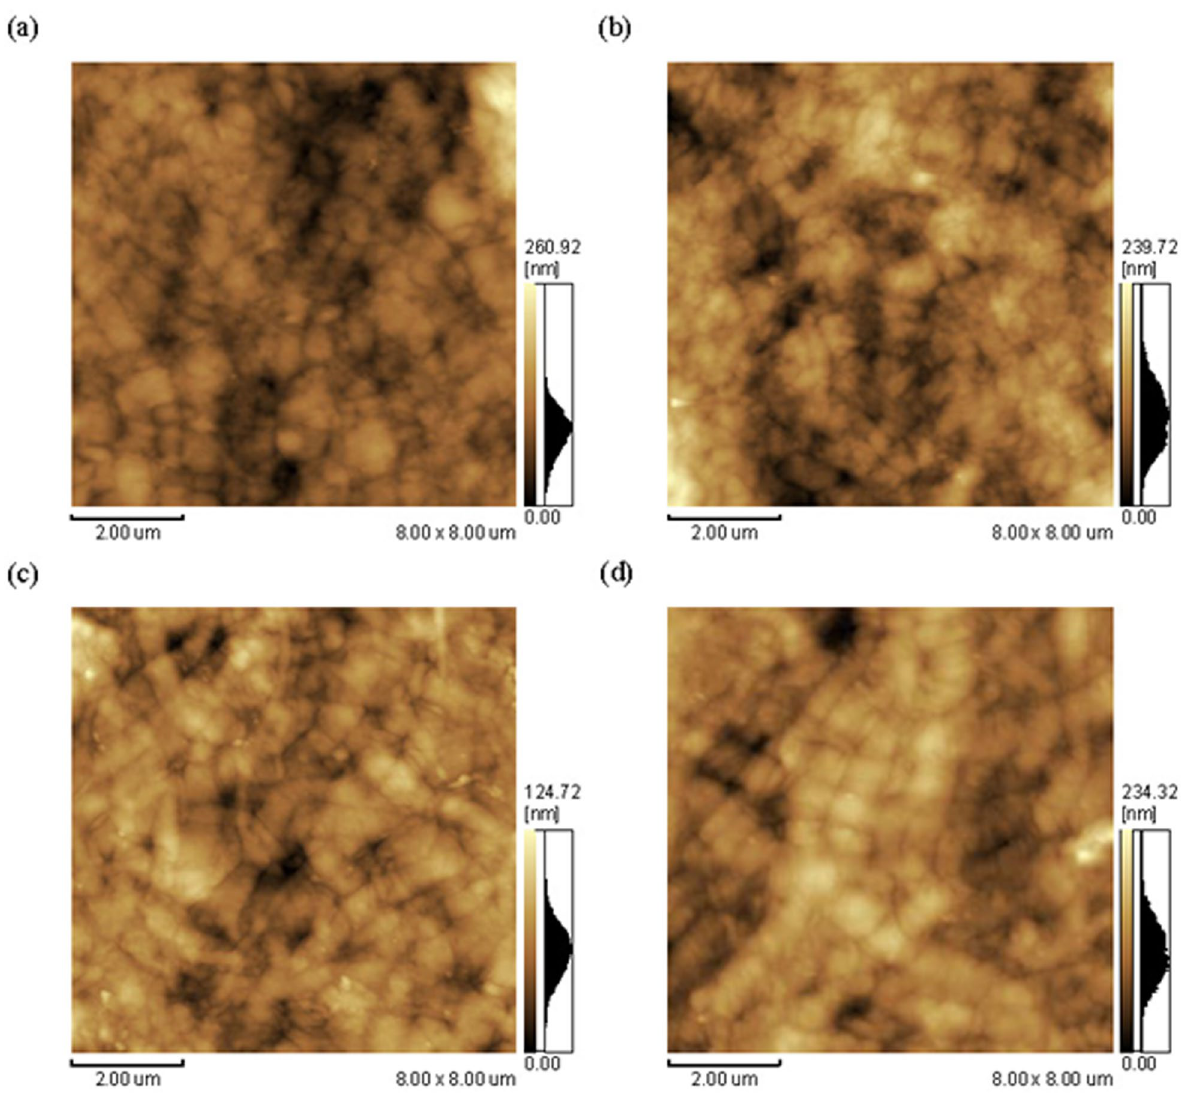
Fig. 2 AFM image of CFOB with different OBSP dosages: a CFOB-0, b CFOB-2, c CFOB-15, d